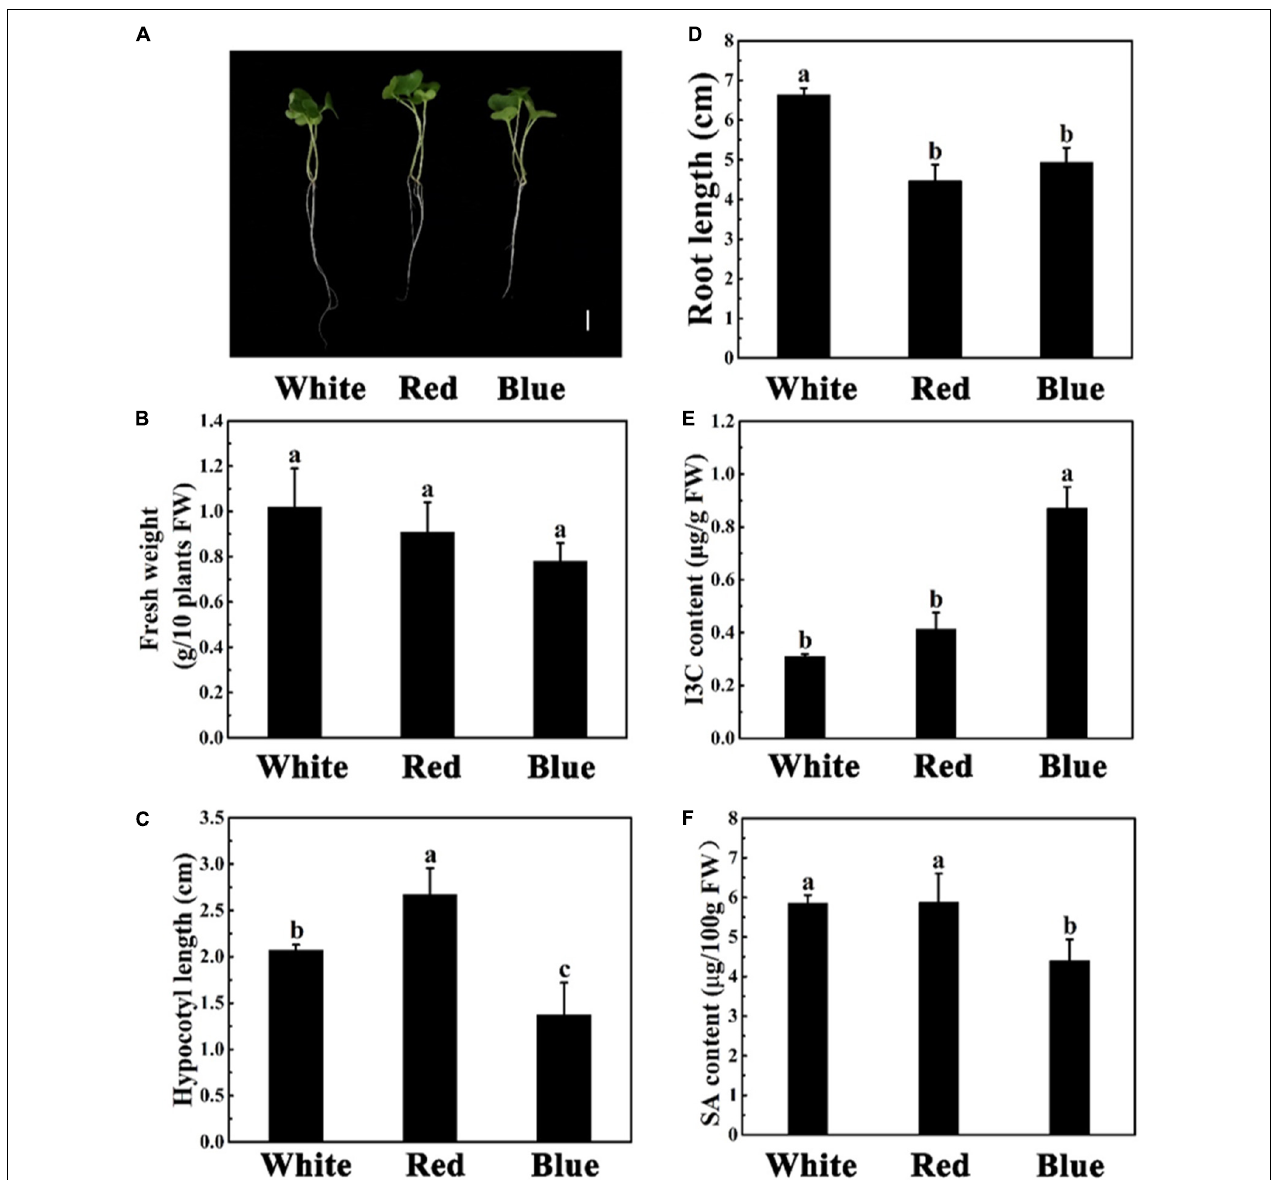
FIGURE 1 | Phenotypic parameters, I3C content, and SA content of different sprouts. Phenotypes of 5-days-old mustard, radish, and broccoli sprouts grown under white light (200 µ mol m − 2 s − 1 ). (A) Phenotypes of 5-days-old mustard, radish, and broccoli seedlings grown under white light. Bar = 1 cm. (B–D) The fresh weight (B) , hypocotyl length (C) , and root length (D) after 5 days of growth. (E,F) Effects of different species of sprouts on the content of I3C (E) and SA (F) . Data represented as means ± SD from three independent experiments. Different letters indicated statistical differences ( P < 0.05).